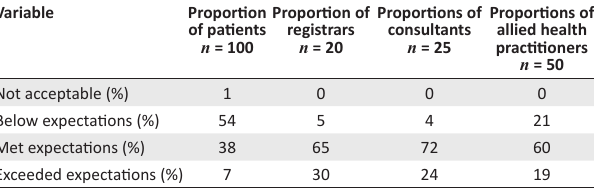
TABLE 1: Average frequencies of ratings by participant group (expressed as a percentage). Variable